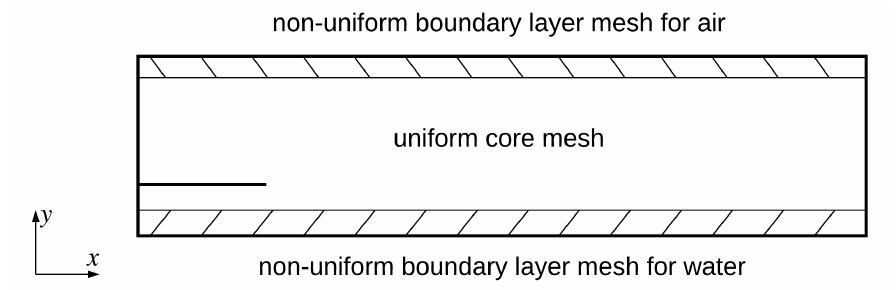
Figure 4. Two non-uniform boundary layer mesh regions are created for the upperWall and lowerWall to ensure that these regions are always resolved by a high-quality mesh. The uniform core mesh guarantees that cells in the interfacial region are always of the same size.